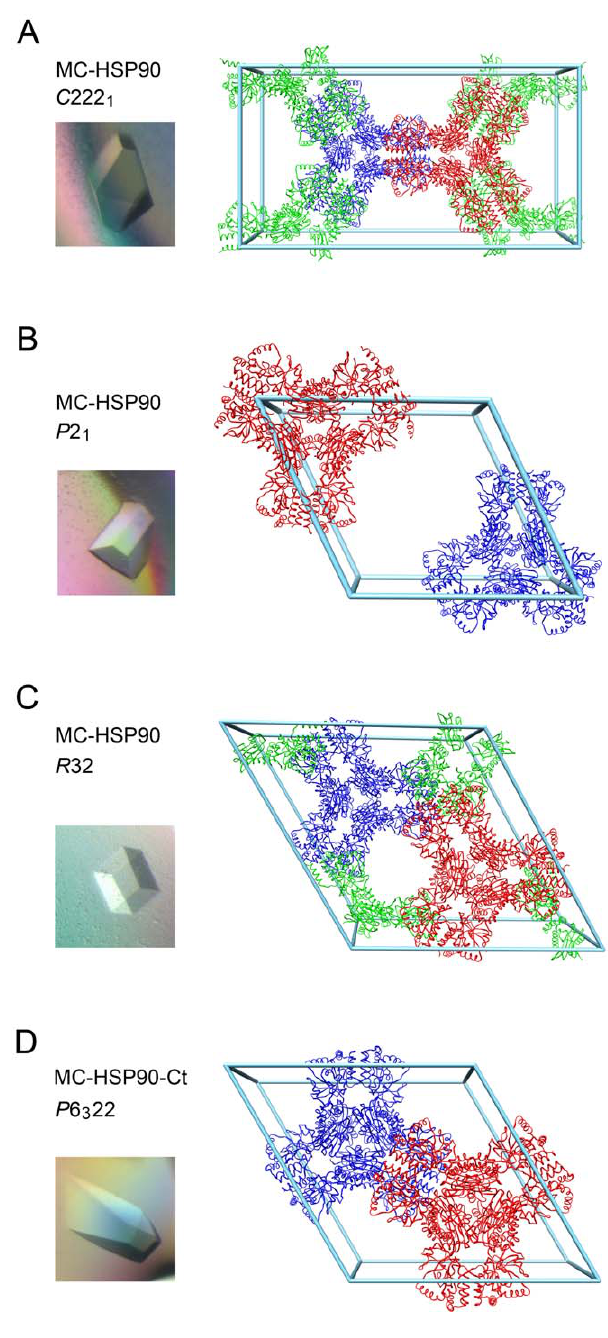
Figure 1. Crystal packing of MC-HSP90 molceules. The pictures of the (A) orthorhombic, (B) monoclinic, (C) rhombohedral, and (D) hexagonal crystals are shown on the left side. The unit-cell contents of the corresponding crystals are shown on the right. All of these crystals contain structurally similar hexamers, which are shown in three different colors and have a variety of arrangements in the unit cells. Although the green models appear to be disintegrated, they indeed form intact hexamers when associated with their symmetry-related mates from the neighboring unit cells. Only the orthorhombic and the hexagonal crystals (A and D) show some resemblance in packing, but they contain proteins with different C-termini.